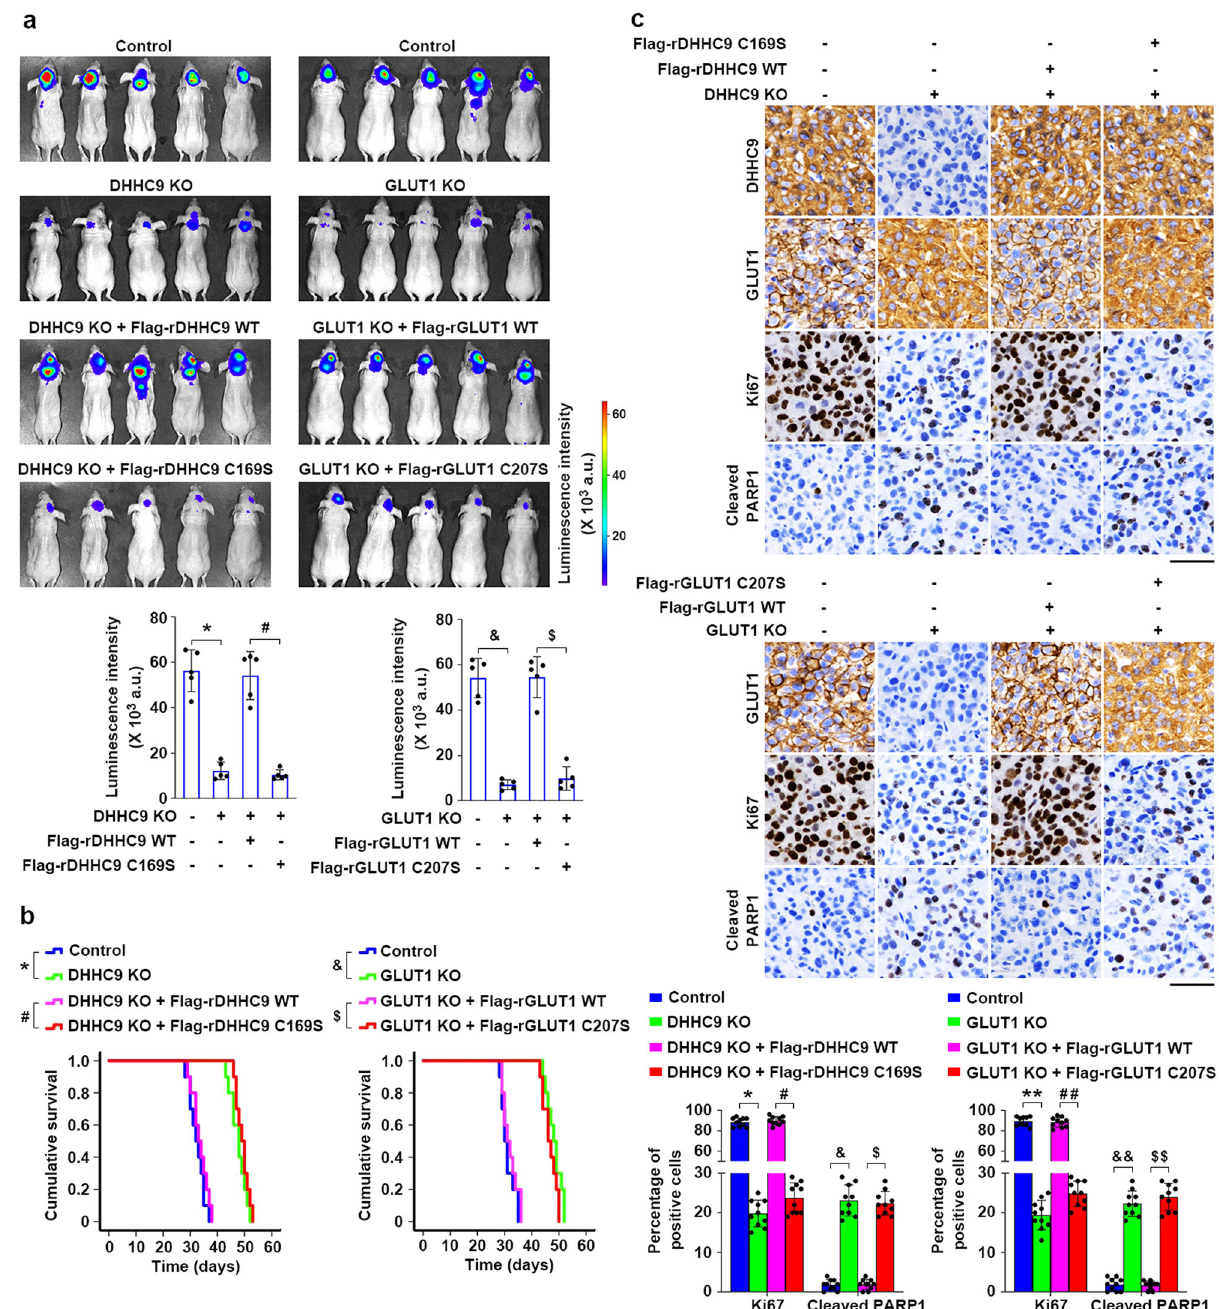
Fig. 5 DHHC9-mediated GLUT1 S-palmitoylation promotes GBM tumorigenesis. a , b Luciferase-expressing DHHC9-knockout U87 cells rescued with Flag-tagged WT rDHHC9 or rDHHC9 C169S and GLUT1-knockout GBM cells rescued with Flag-tagged WT rGLUT1 or rGLUT1 C207S were intracranially injected into athymic nude mice ( n = 5). Luminescence intensity derived from tumors was measured and relative luminescence intensity is shown ( a ). Data were collected from n = 5 mice per group, and the mean ± SD values are shown ( a ). The survival times of the mice ( n = 10) were recorded ( b ). a * P = 2.57E-06, # P = 1.16E-05, & P = 9.63E-06, $ P = 1.82E-05. b * P = 4.00E-06, # P = 3.00E-06, & P = 5.00E-06, $ P = 4.00E-06. c Representative images of immunohistochemical staining of DHHC9, GLUT1, Ki67, and cleaved PARP in paraf fi n-embedded xenograft tumor tissues collected from the indicated groups (top and middle). Scale bar, 50 μ m. The expression levels of Ki67 and cleaved PARP1 were quanti fi ed for ten microscopic fi elds of the tumor samples (bottom). The mean ± SD values are shown. * P = 3.87E-19, # P = 1.44E-18, & P = 3.33E-12, $ P = 8.58E-14, ** P = 1.15E-18, ## P = 4.84E-18, && P = 5.63E-13, $$ P = 1.14E-13. P values were determined by the two-tailed Student ’ s t test ( a , c ) and the two-tailed log-rank test ( b ). a.u., arbitrary unit ( a ). Source data are provided as a Source Data fi on DHHC9-mediated GLUT1 S-palmitoylation, unlike normal astrocytes which primarily depend on other mechanisms to maintain their glycolysis, highlighting that DHHC9 could be a potential target for cancer cell-speci fi c inhibition of glycolysis.